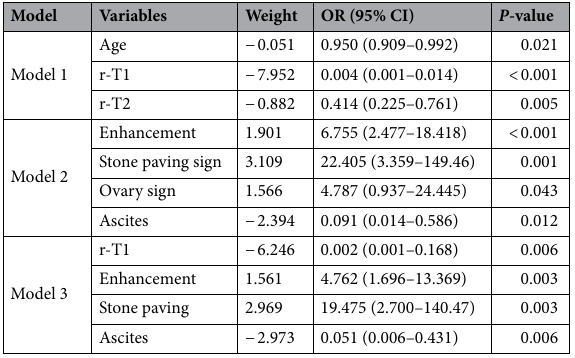
Table 4. Multivariate logistic regression of three models for differentiation of fibrotecoma and BLM. OR odds ratio, AUC Area under curve, SEN sensitivity, SPC specificity, r-T1 relative T1 value, r-T2 relative T2 value.